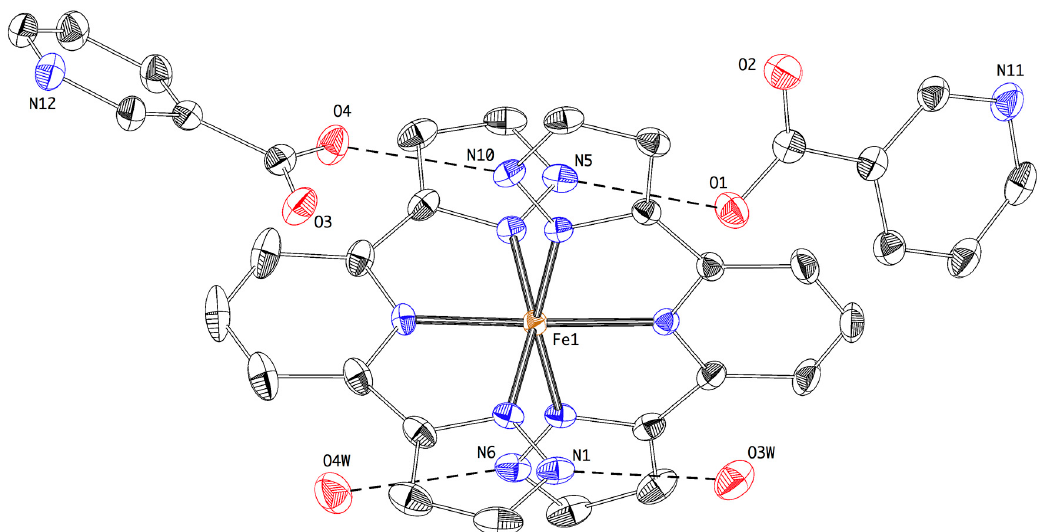
Figure 1. Thermal ellipsoid plot of the crystal structure of 1 · 4H 2 O showing the [Fe(bpp) 2 ] 2+ complex, the two crystallographically independent nicotinate anions, and the two water molecules present in the second coordination sphere of the iron site. Dashed lines refer to H bonds. Thermal ellipsoids are drawn at a 50% probability level. H atoms are not shown. Table 1. Summary of crystal data.